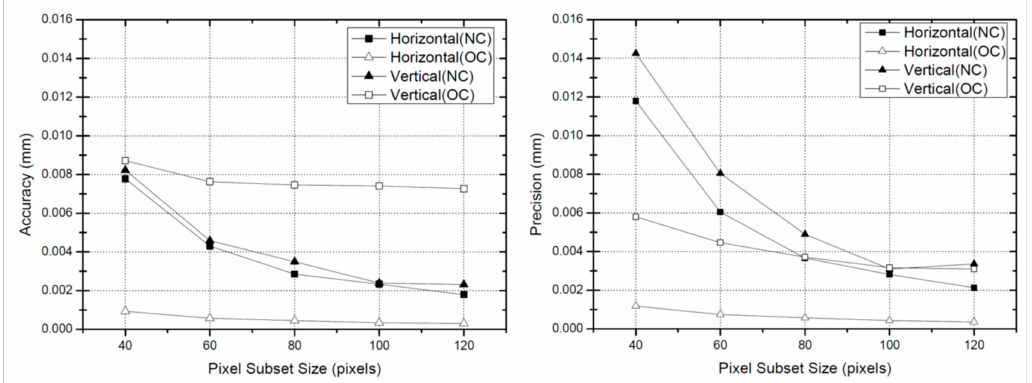
Figure 5. Accuracy and precision of the GeoPIV program: accuracy (left) and precision